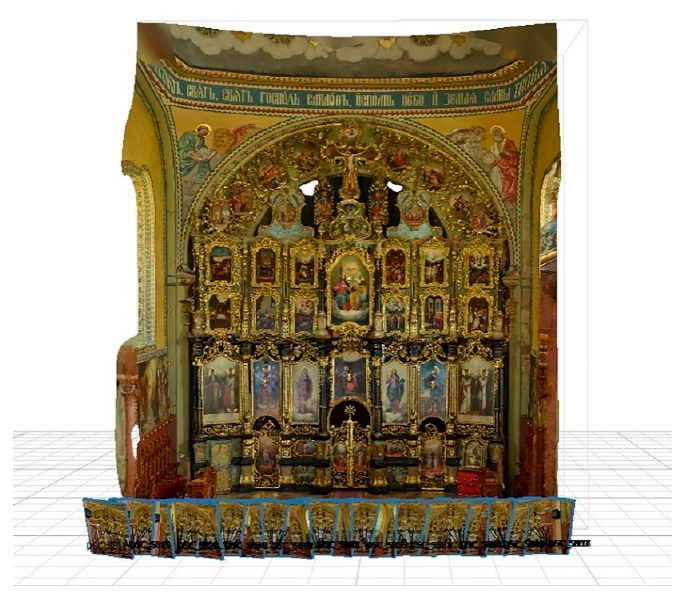
Figure 2. The mesh generated from depth-maps.